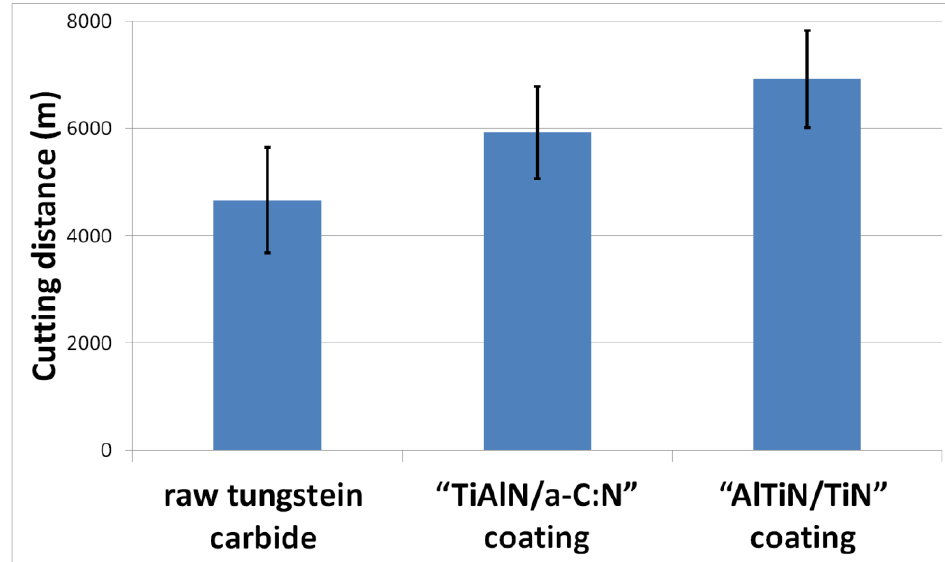
Figure 17. The effect of the 5 μm thick coating on the cutting distance needed for the milling tool wear VB = 0.2 mm [8]. wear VB = 0.2 mm